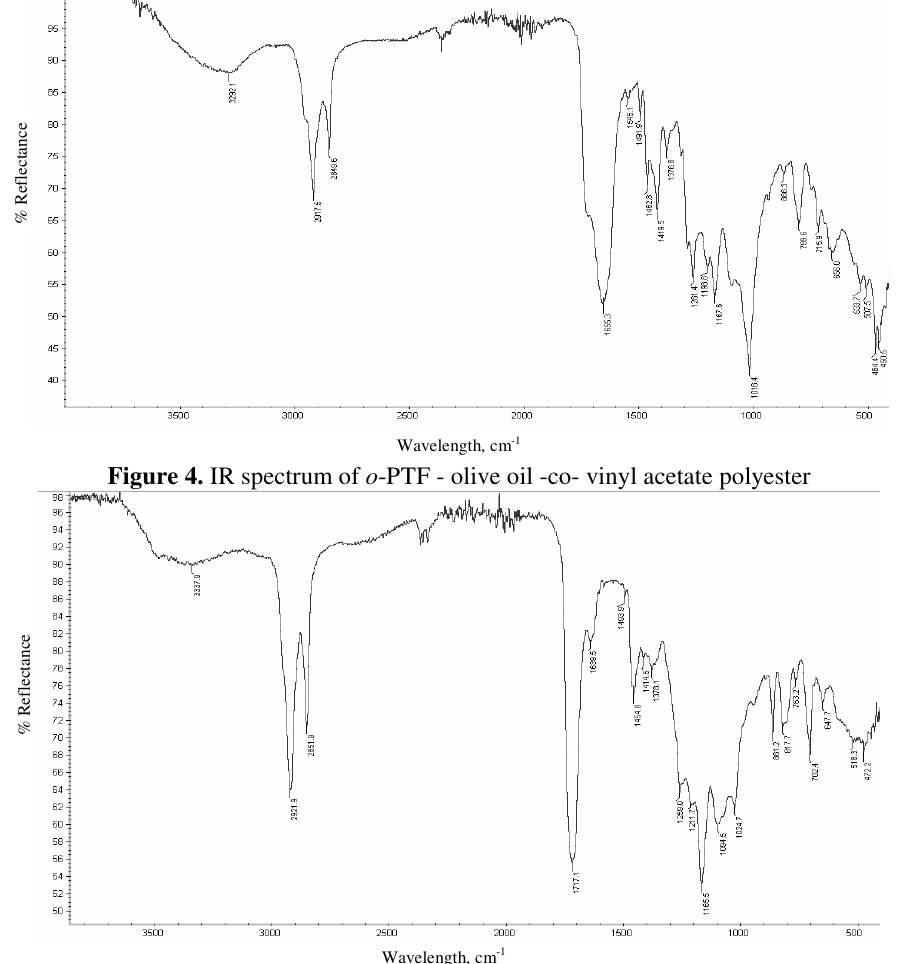
Figure 5. IR spectrum of o -PTF - olive oil -co N -vinyl pyrrolidone